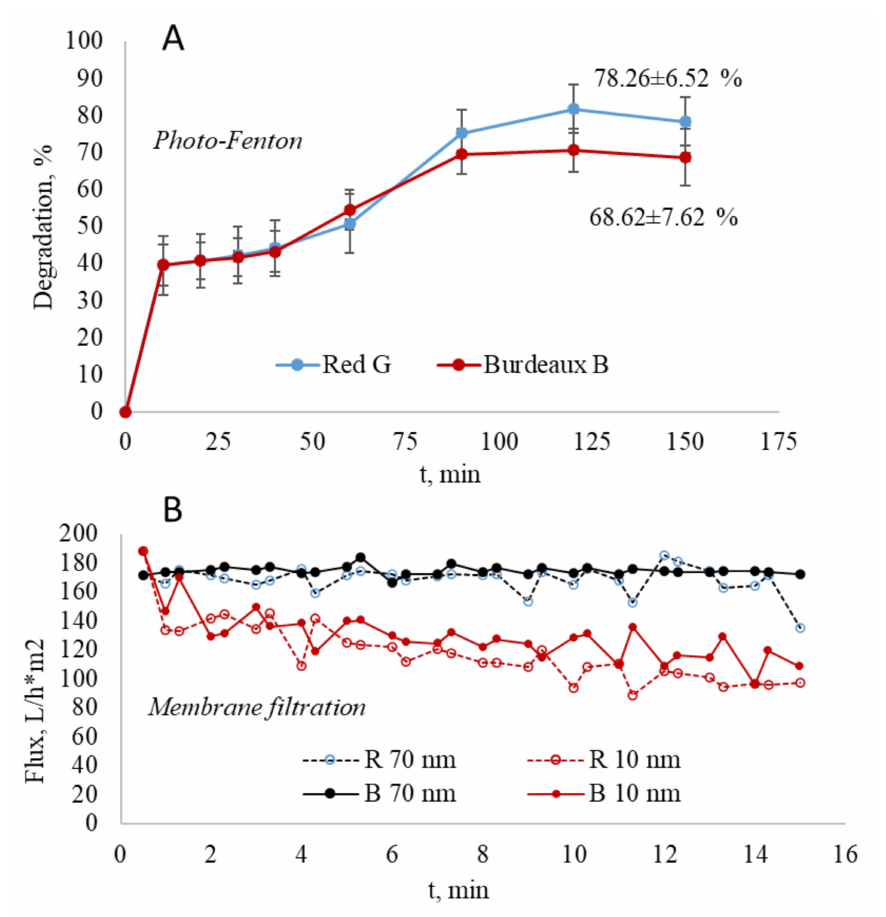
Figure 10. ( A ) Bordeaux B and Red G degradation applying photo-Fenton process; ( B ) membrane filtration flux using two pore sizes (70 and 10